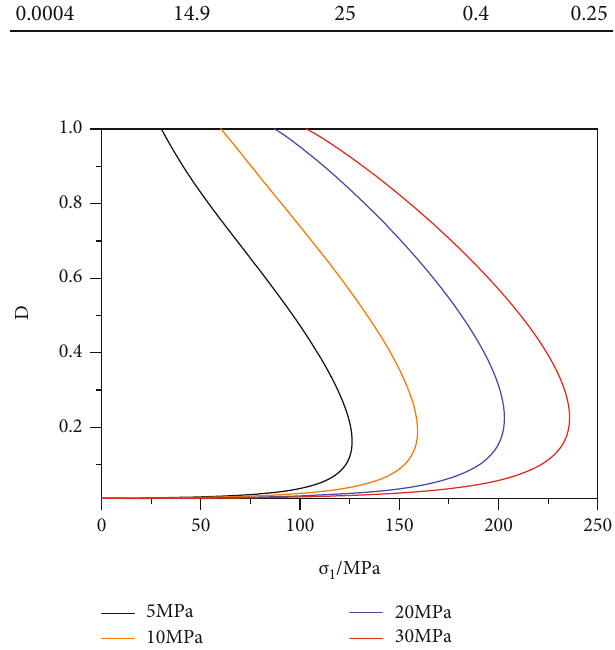
Figure 17: Damage-axial stress curves under di ff erent con fi ning